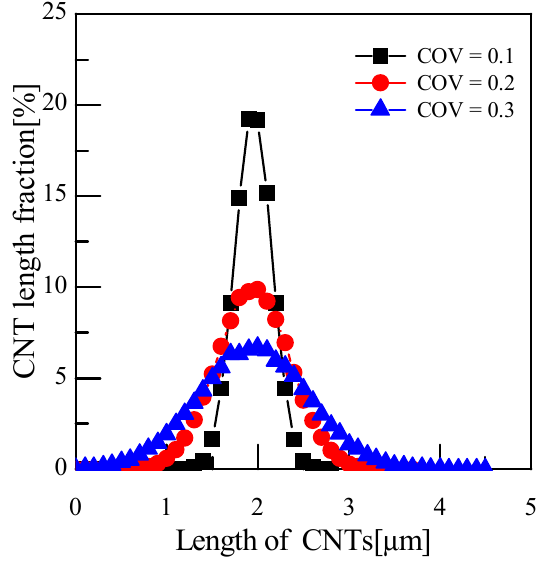
Figure 1. CNT length fraction according to COV.